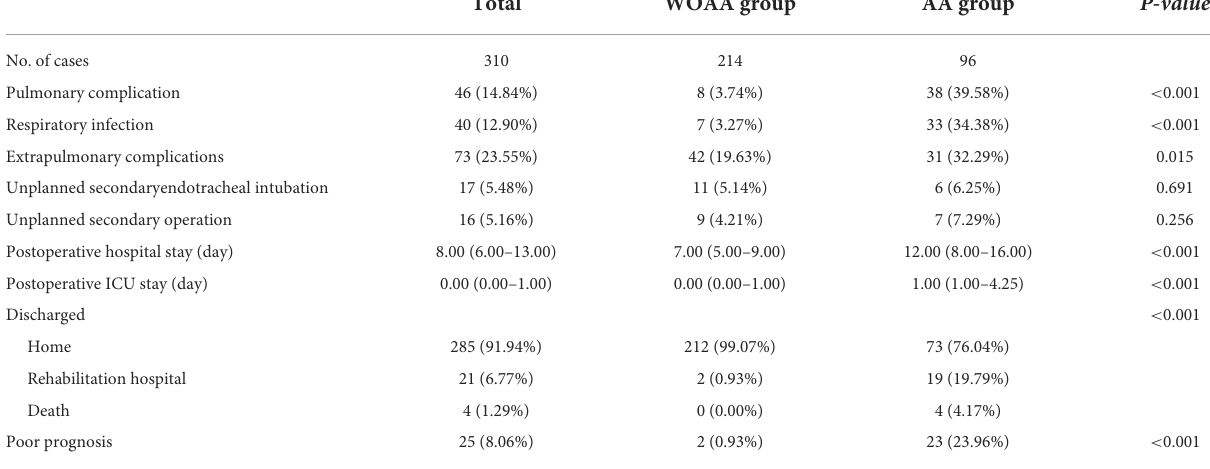
TABLE 2 Outcome variables, stratified by AA